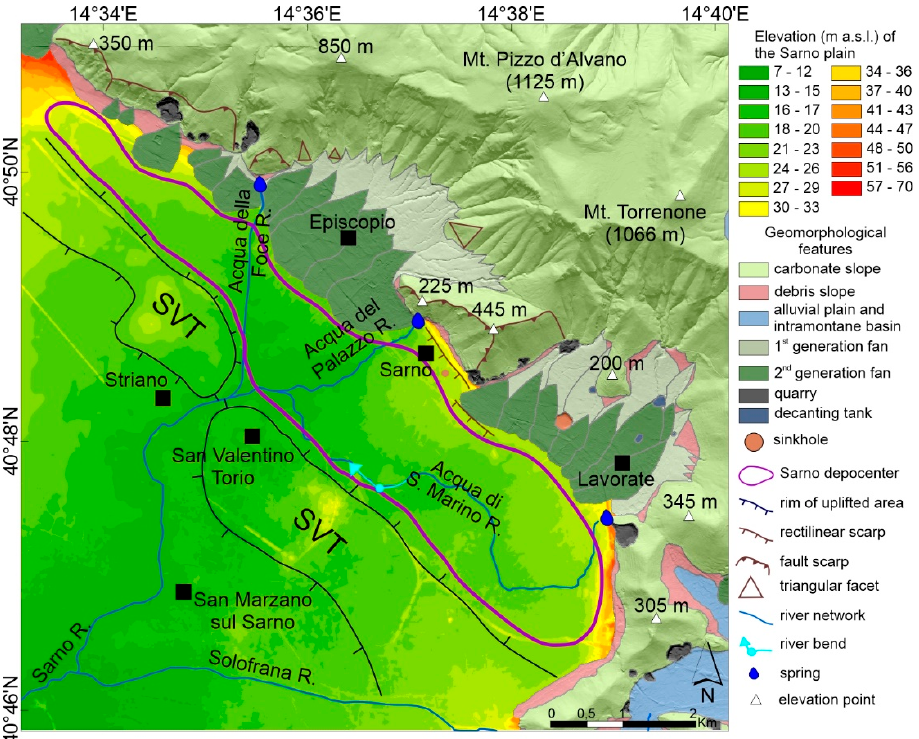
Figure 2 . Geomorphological map of the inner sector of the Sarno plain and the adjoining western slope of the Sarno mountains [modified from 20].